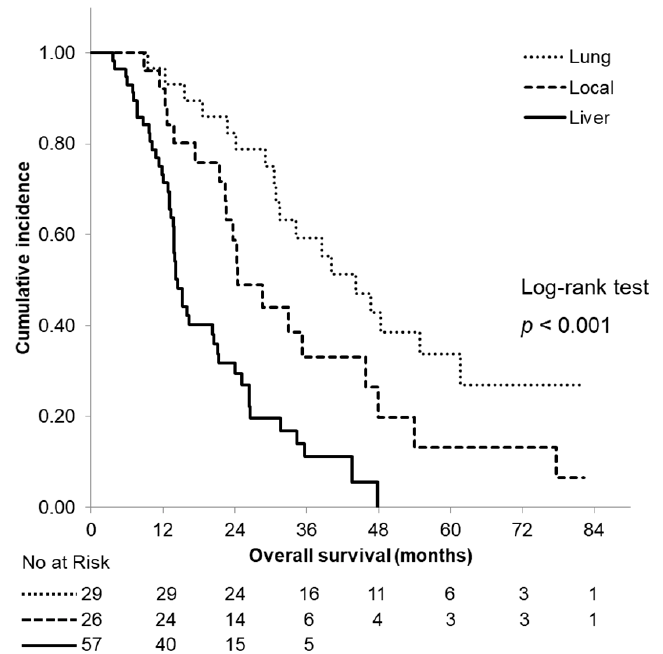
Figure 4. Kaplan–Meier curves of overall survival according to the site of the first recurrence. The median overall survival time was 14.5 months, 24.4 months and 44.2 months in patients who initially exhibited a liver metastasis, a local recurrence and a lung metastasis,